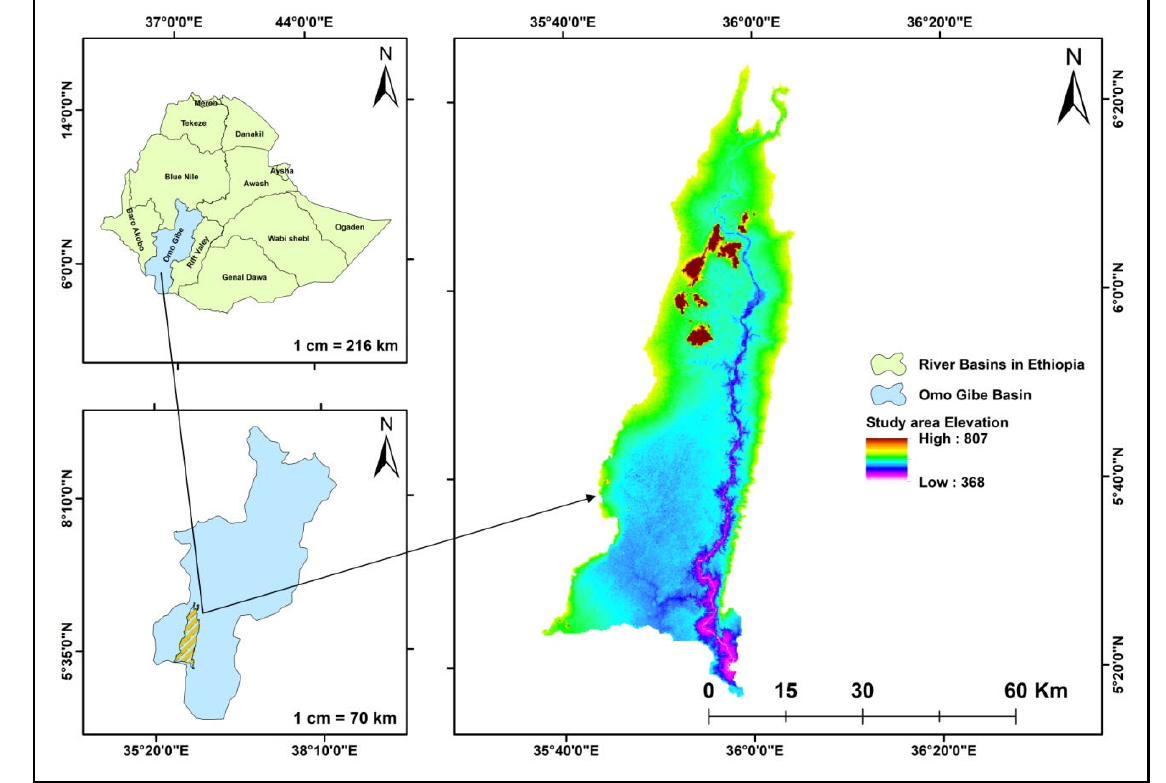
Figure 1. Location of the study area in relation to river basins in Ethiopia and the Omo ‐ Gibe basin.